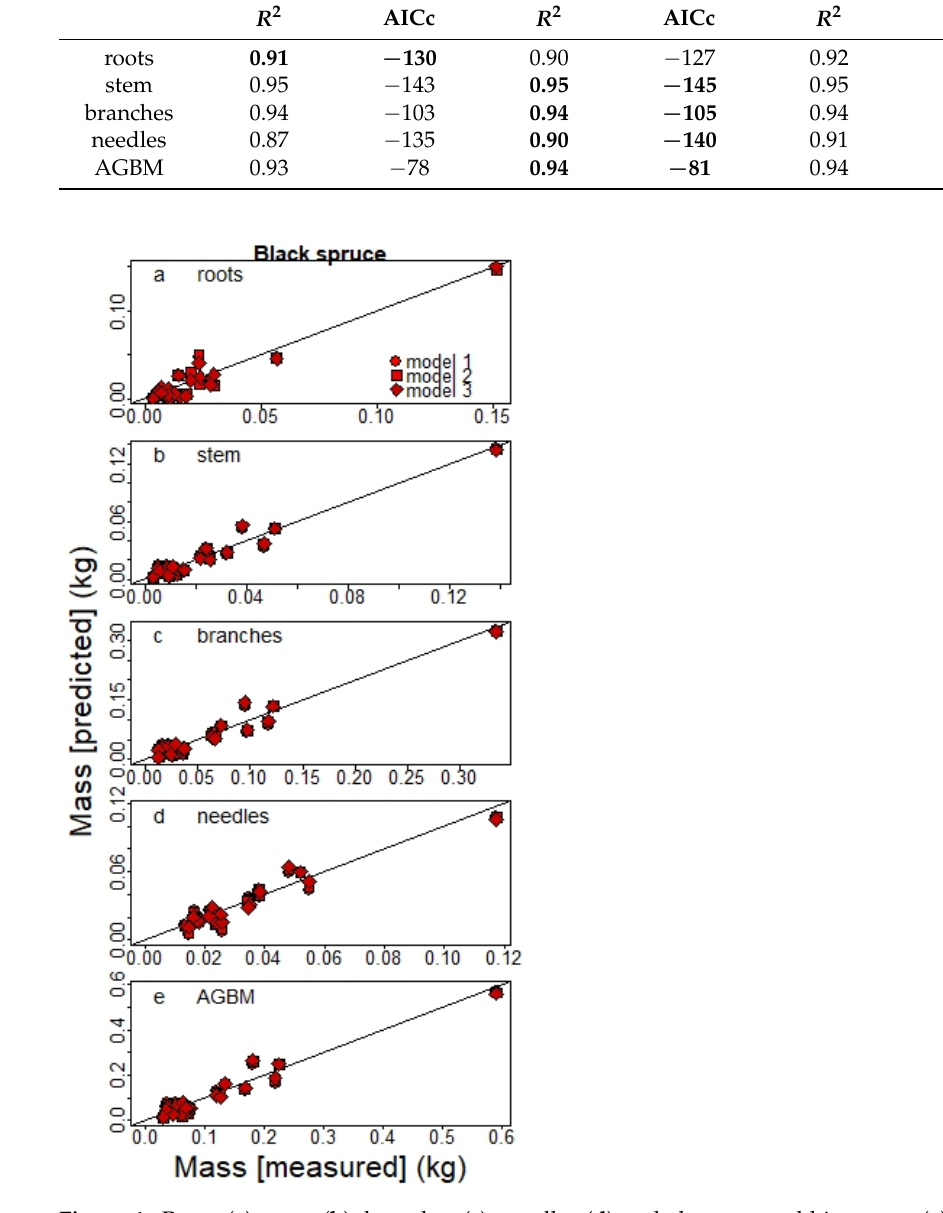
Figure 4. Roots ( a ), stem ( b ), branches ( c ), needles ( d ) and aboveground biomasses ( e ) (AGBM) predicted by the three models vs. measured values for black spruce ( n = 21) trees (height < 1.3 m) sampled in boreal open woodlands of